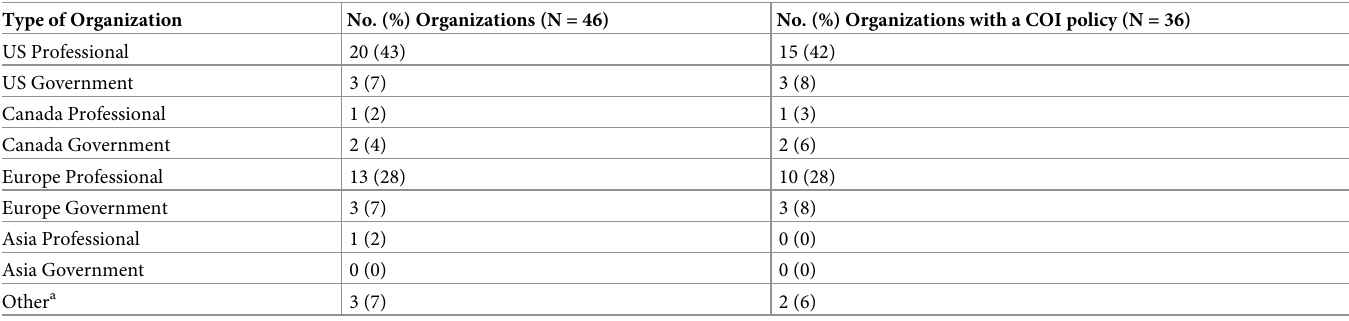
Table 2. Organization